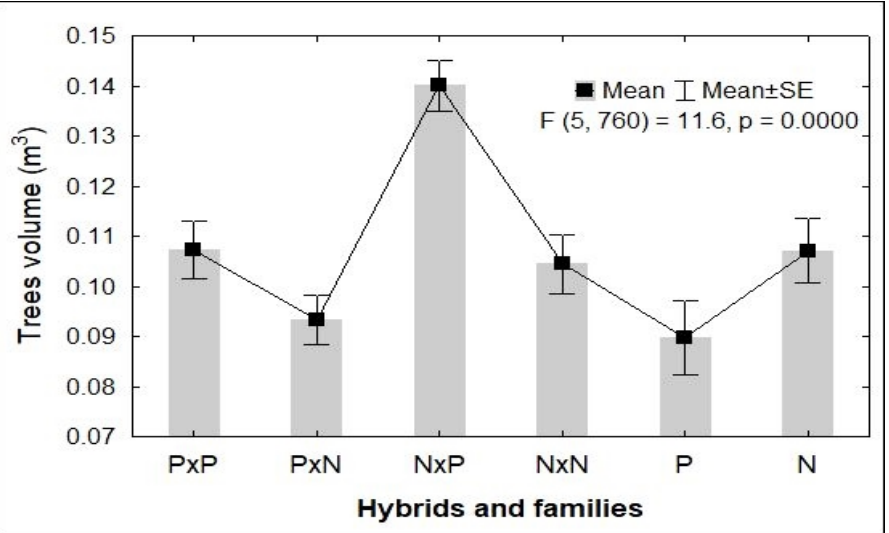
Figure 3. Mean Tv values of pendula ( P ) and normal ( N , pyramidalis ) crown forms and their